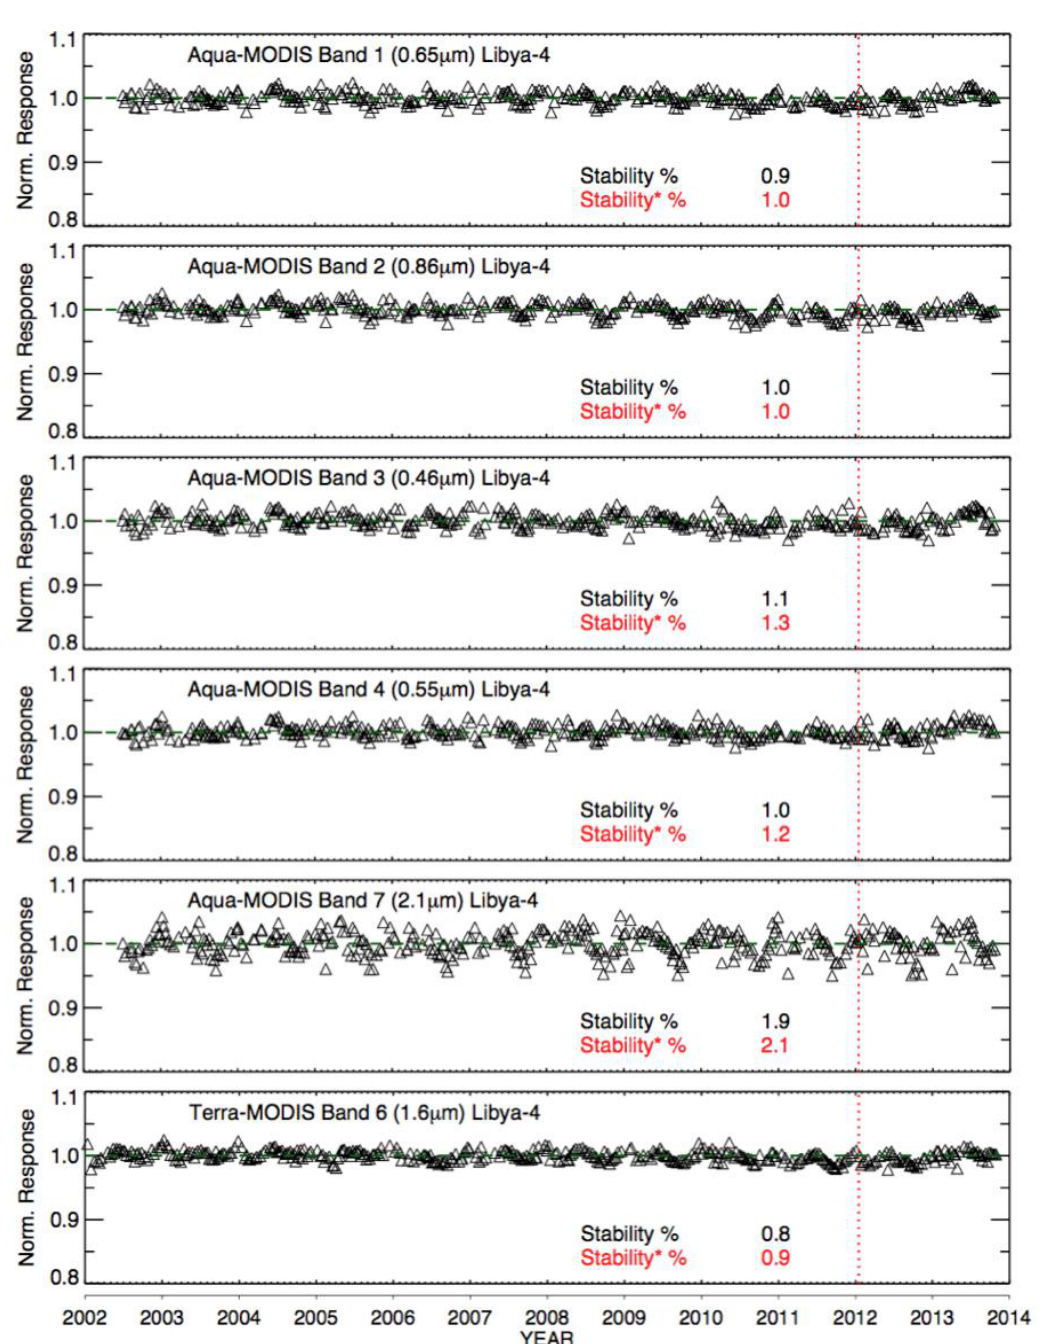
Figure 5. The normalized desert responses for MODIS RSB during the 2002–2013 time period. The standard deviation (stability) for the whole record and the VIIRS time frame is labeled in black and red (*) respectively. The dotted horizontal red line demarcates the beginning of the VIIRS